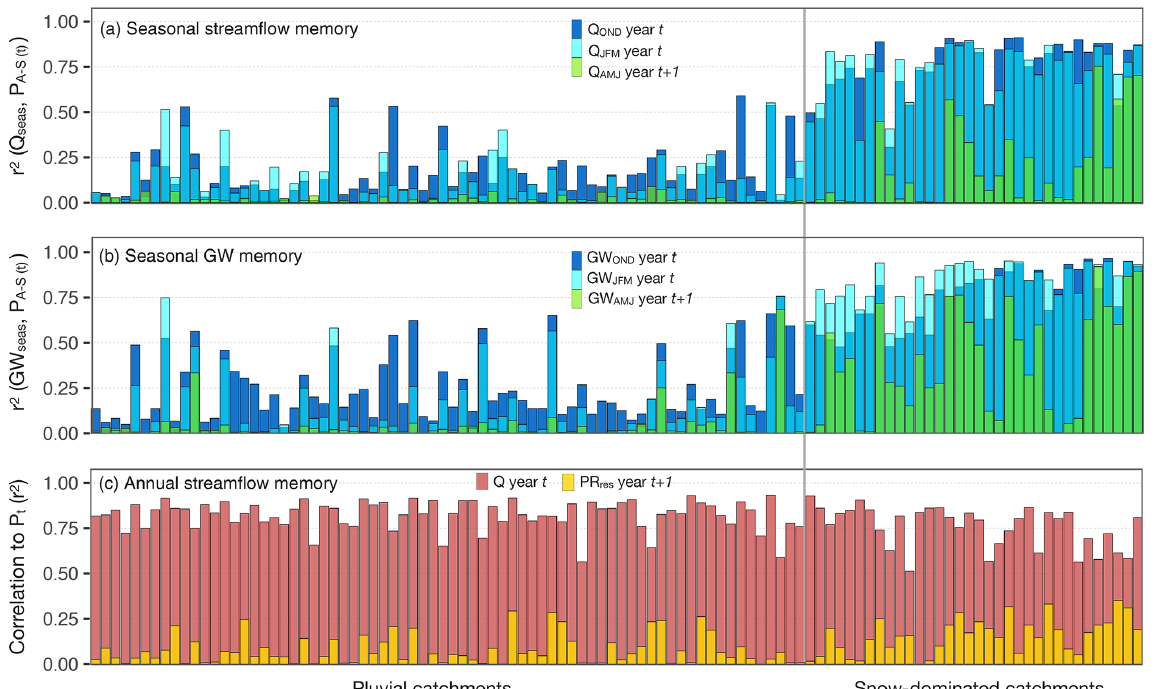
Figure 3. Hydrological memory represented by different indices. Panel (a) presents the variance in seasonal streamflow explained by the variance in autumn–winter precipitation of year t ( P A–S (t) ). Panel (b) presents the seasonal GW correlation to P A–S (t) . Panel (c) shows the r 2 between annual precipitation and annual streamflow ( r 2 of P–R regressions) and the variance of the P–R residuals explained by the precipitation from the preceding